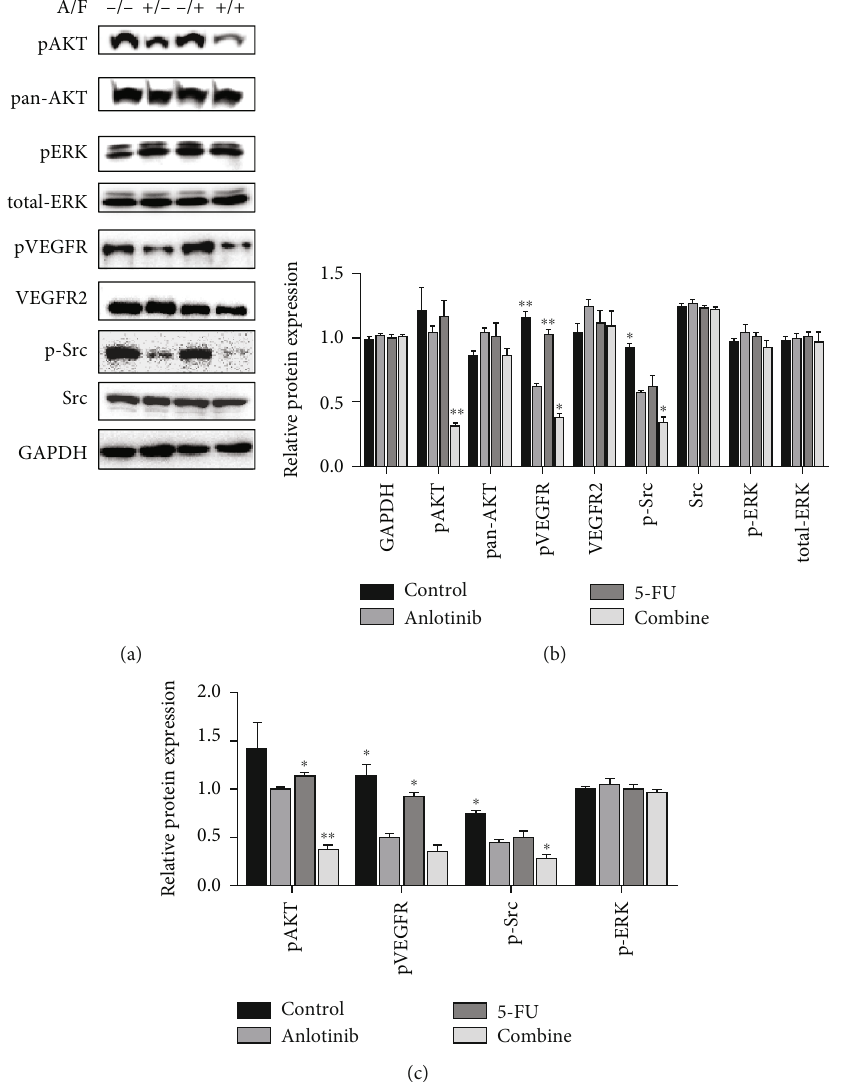
Figure 5: Anlotinib combined with 5-FU a ff ected cell proliferation through Src/AKT pathway in the H446 cells through Western blot. (a)p -AKT/pan-AKT, p-ERK/total ERK, pVEGFR/VEGFR2 p-Src/Src, and GAPDH in each treatment group were tested by Western blot. (b) The relative protein expression of which relative to GAPDH was analyzed by GraphPad Prism. (c) The relative protein expression of pAKT/pERK/pVEGFR/p-Src relative to pan-AKT/total-ERK/VEGFR2/Src was analyzed by GraphPad Prism. The results are from the three independent experiments. ∗ P < 0 : 05 and ∗∗ P < 0 : 01 compared with